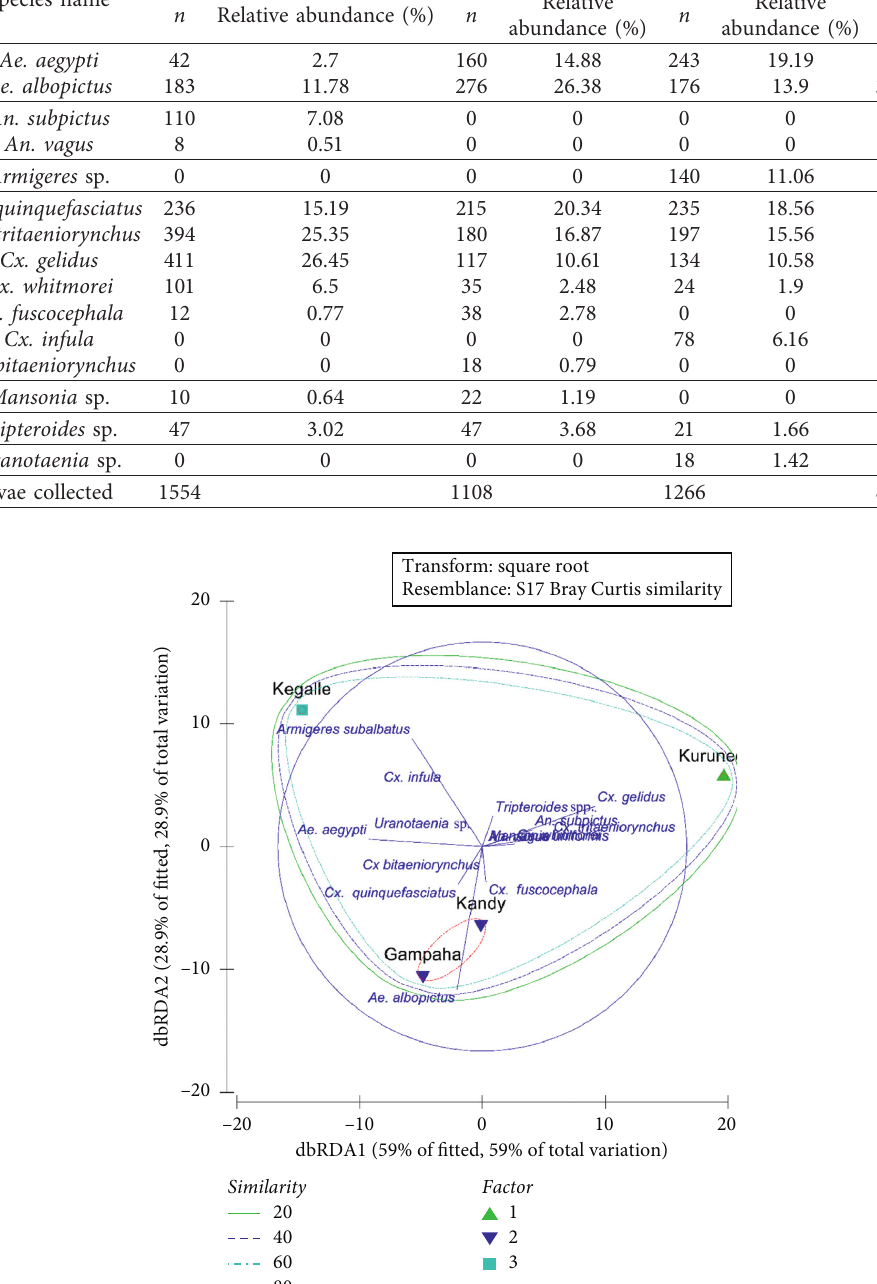
Table 2: The abundance of mosquito species in Kurunegala, Gampaha, Kegalle, and Kandy districts, Sri Lanka. Genera